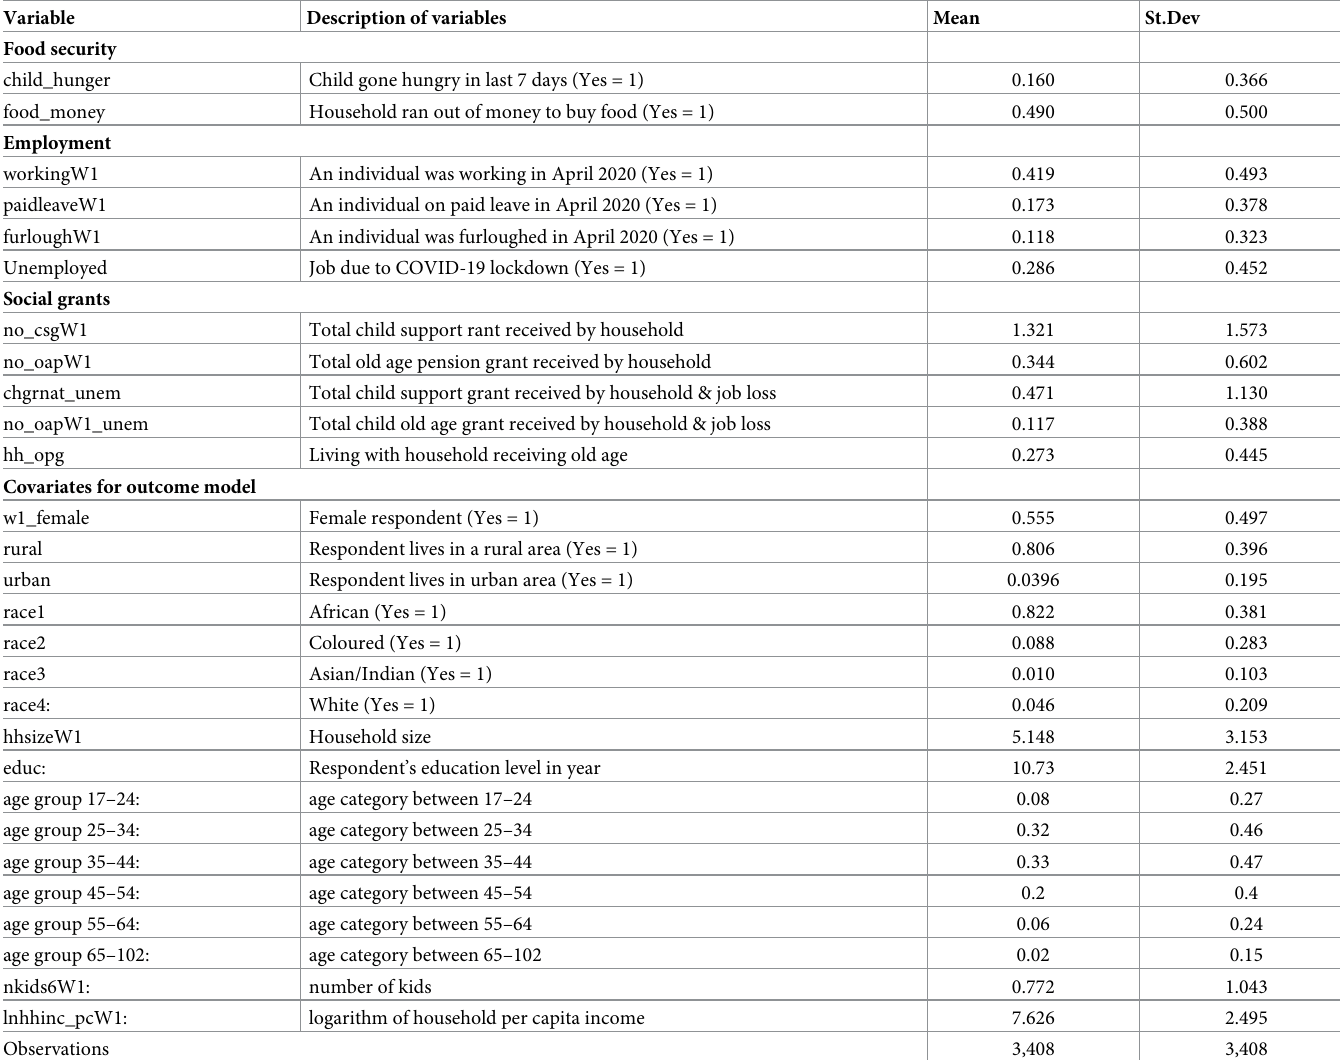
Table 1. Descriptive statistics of variables used in the